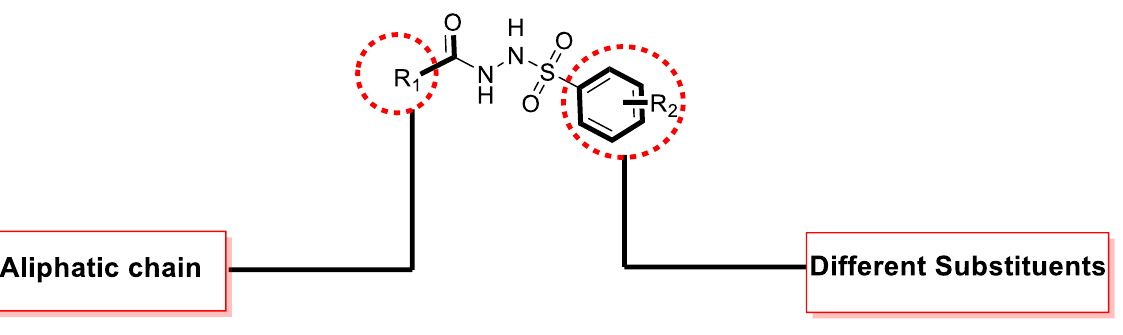
Figure 1. General representation of molecules.